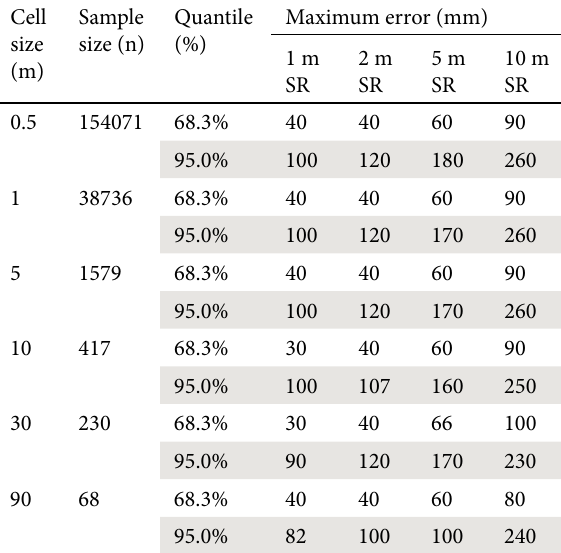
Table 3. Two quantiles for the different combinations of resolu- tion (cell size) and search radius (SR)